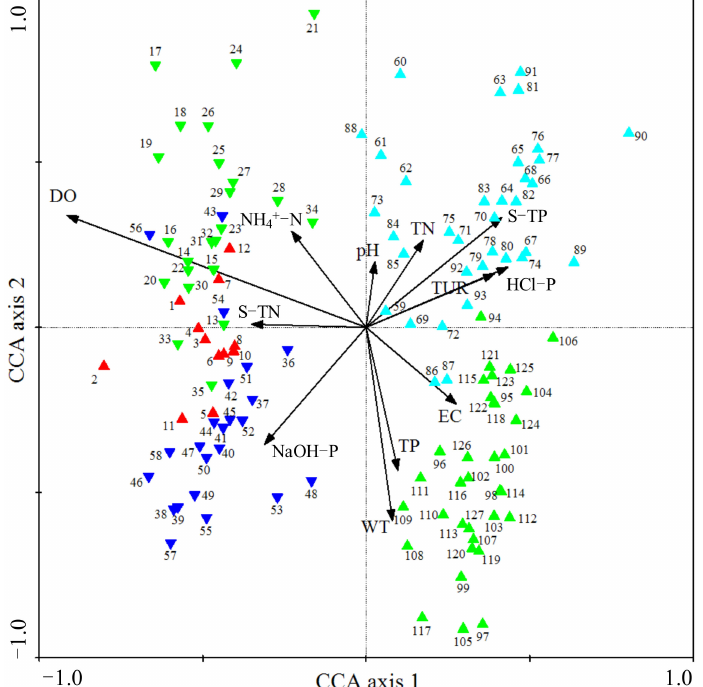
Figure 11. Results of CCA plotted for the effects of main environmental factors on the sediment microbial communities at sites. Environmental factors are expressed as black lines with arrows. S-TN: sediment total nitrogen, S-TP: sediment total phosphorus. Samples from August 2018: red up-triangle; samples from October 2018 to February 2019: green down-triangle; samples from April to June 2019: blue down-triangle; samples from August to December 2019: cyan up-triangle; samples from April to June 2020: green